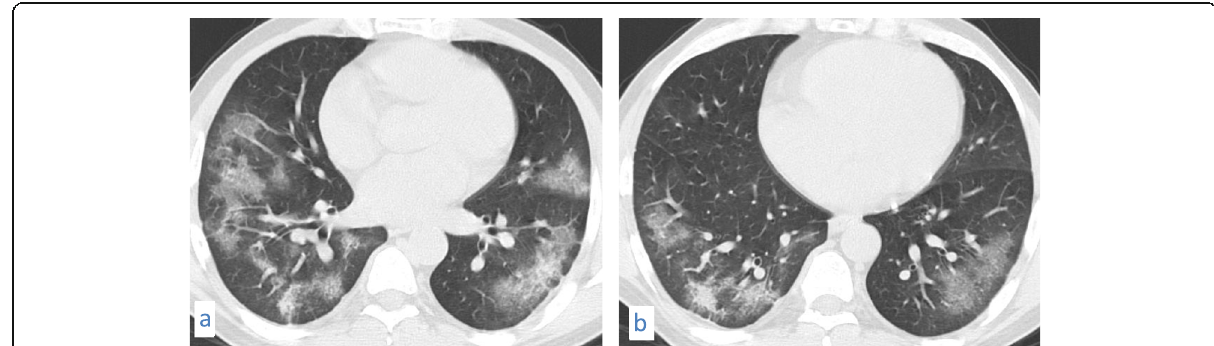
Fig. 11 A 37-year-old male patient with COVID-19, CT chest axial images ( a ) and ( b ) show predominantly peripheral crazy paving with vascular thickening and traction bronchiectasis within. The affection is mostly in both lower lobes. A right peripheral basal patch of consolidation is noted (cid:1) Loculated right lateral hydropneumothorax was seen in one case (0.45%). (cid:1) Bilateral pleural plaques with foci of calcification were seen in one case with associated asbestos exposure (Fig. 5).